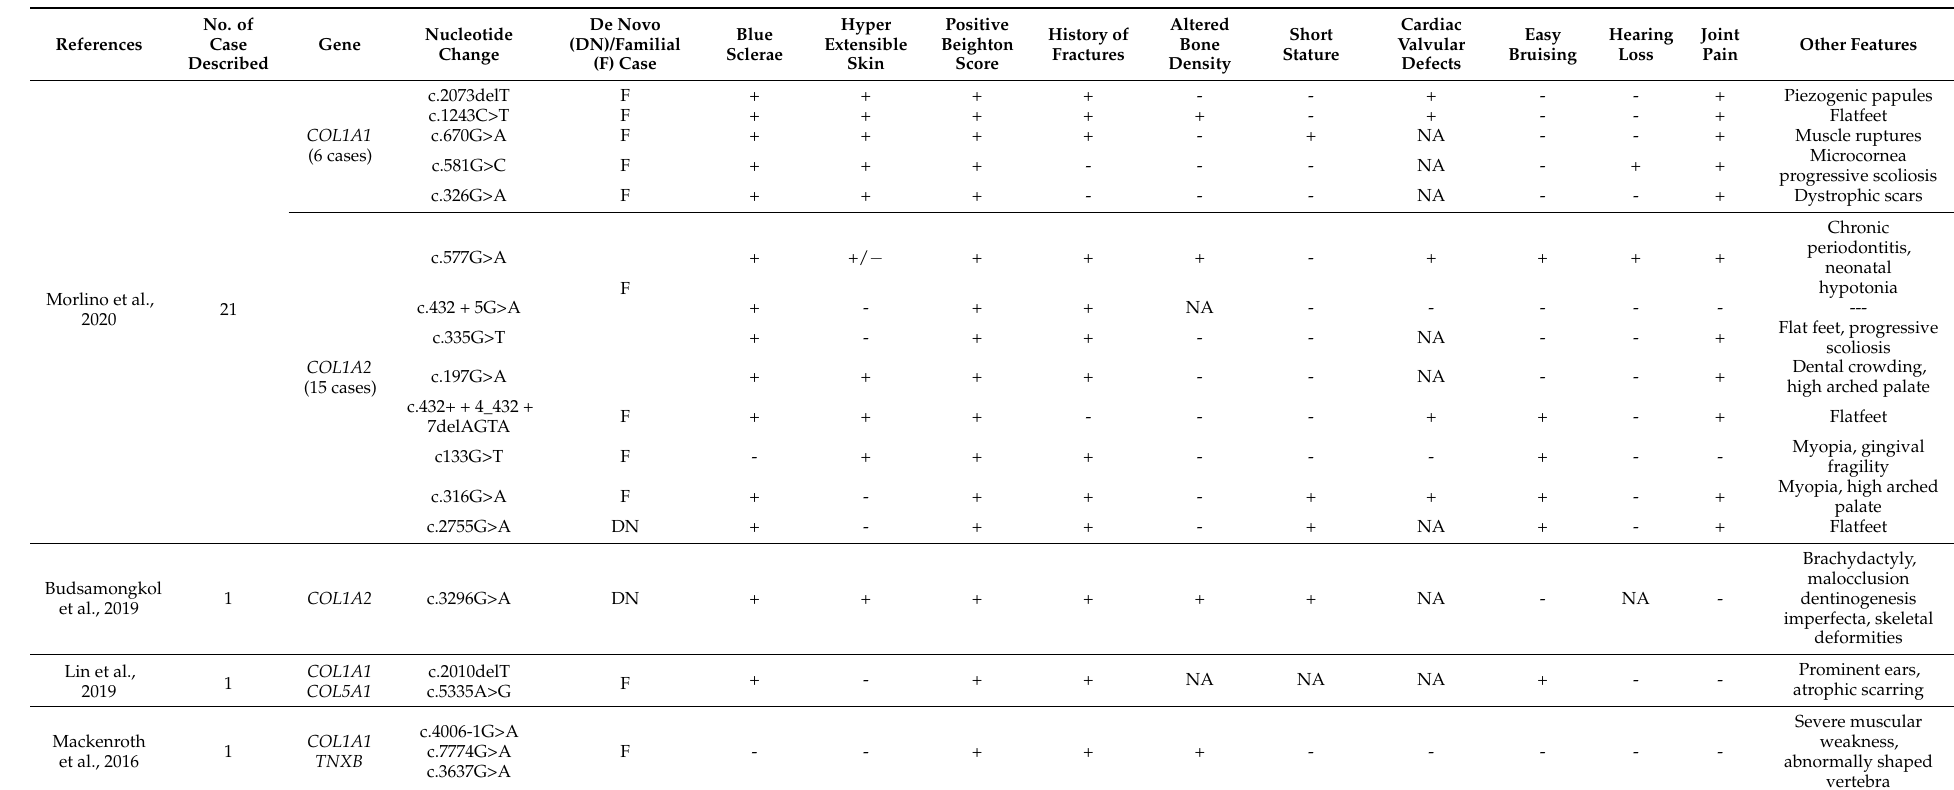
Table 1. Clinical features of patients with OI/EDS syndrome reported in